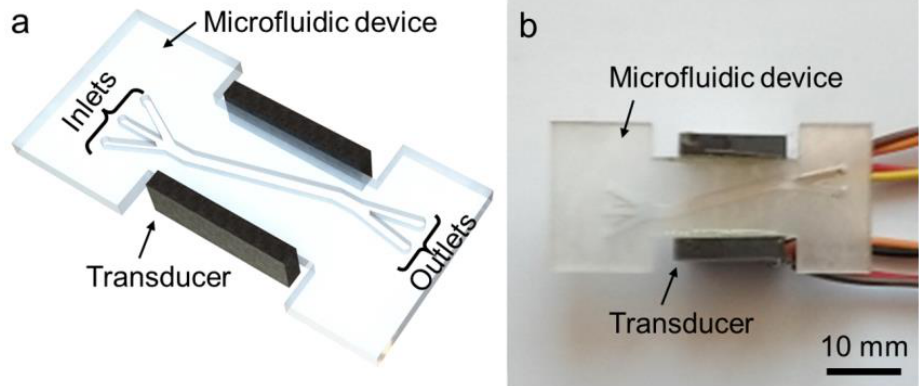
Figure 1. The 3D printed and assembled microfluidic device. ( a ) Schematic depiction of the device geometry. ( b ) Actual picture of the acoustic device.